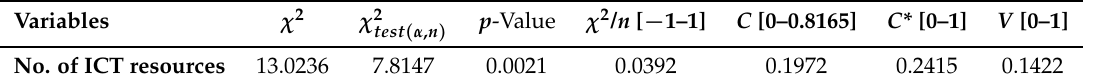
Table 6. Association parameters and χ 2 test between the grades obtained by students and the number of ICT resources used during the course. The test has been computed qualitatively, with grades considered as categorical variables.